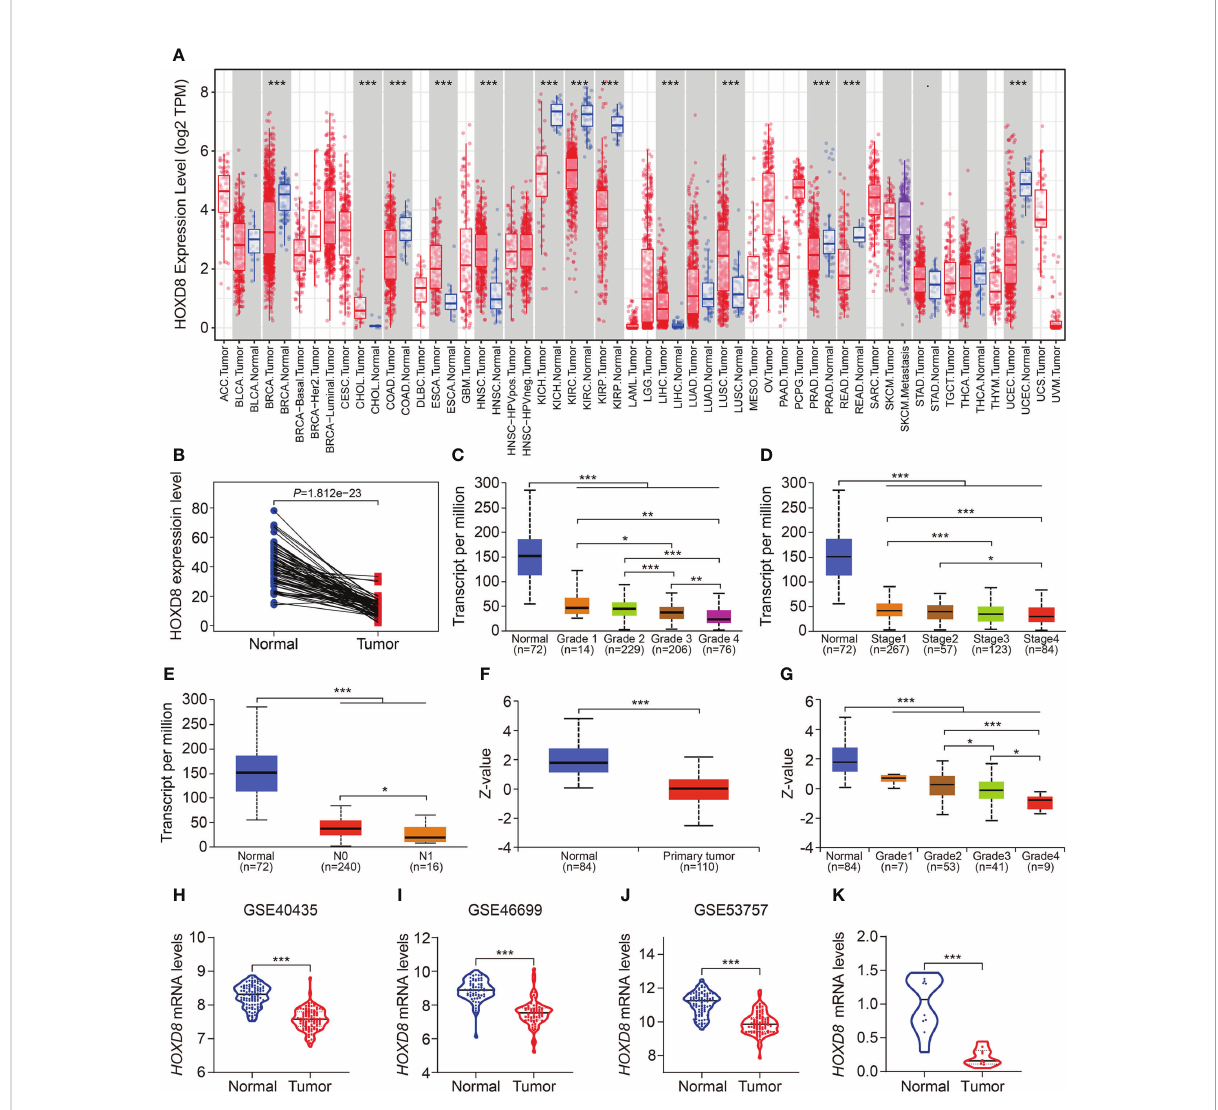
FIGURE 12 HOXD8 was downregulated in KIRC and correlated with tumor progression. (A) The expression pro fi les of HOXD8 in various types of tumors. (B) Comparison of the expression of HOXD8 in KIRC tissues and match non-tumor tissues. (C-E) The expression of HOXD8 in KIRC tissues with different tumor grade, stage, and N status. (F) The protein level of HOXD8 in KIRC tissues and normal tissues. (G) The protein level of HOXD8 in KIRC tissues with different tumor grade. (H-J) Comparison of the expression of HOXD8 in normal and tumor tissues in GSE40435, GSE46699, and GSE53757 database. (K) qRT-PCR was used to detect HOXD8 expression in clinical samples * P < 0.05; ** P < 0.01; *** P <